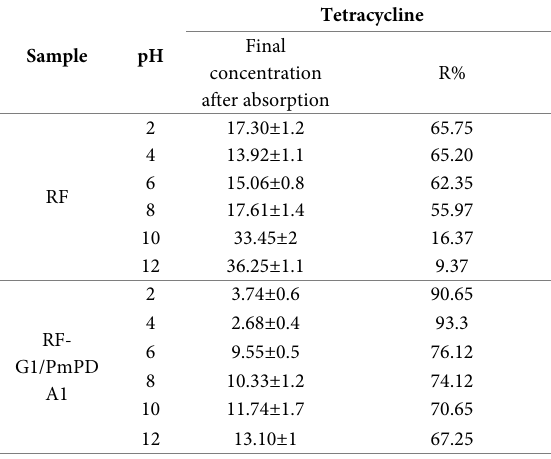
Table 4. The absorption amounts of the